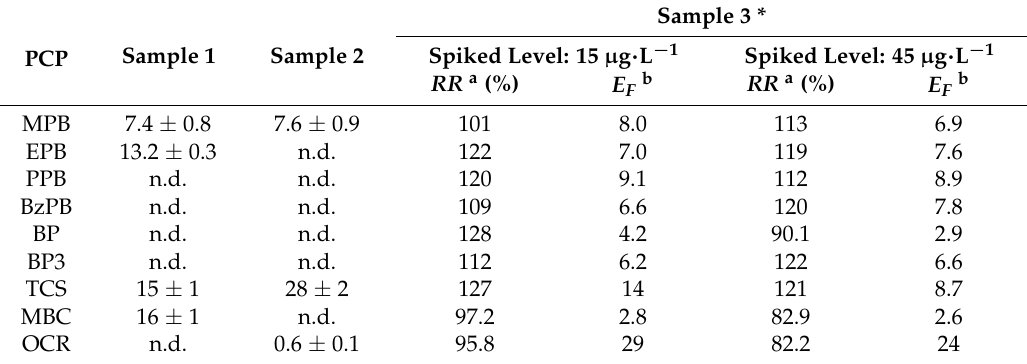
Table 2. Contents of PCPs ( µ g · L − 1 ) found in the analysis of wastewater samples with the entire D- µ SPE-UHPLC-UV method proposed for the monitoring of PCPs, and recovery study in these samples at two spiked levels.